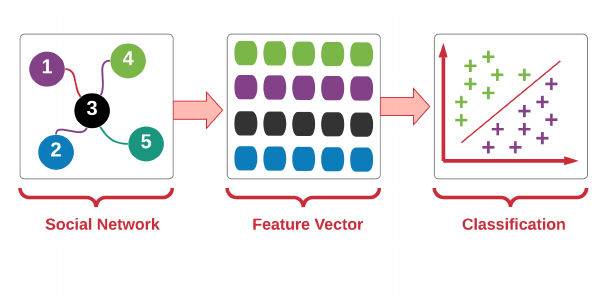
Figure 10. Flowchart of Classification